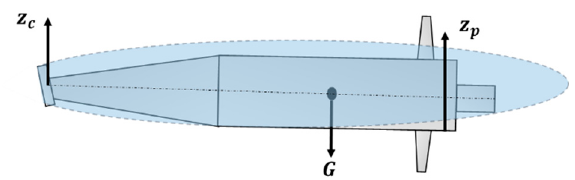
Figure 2. Motion scheme for straight level flight.